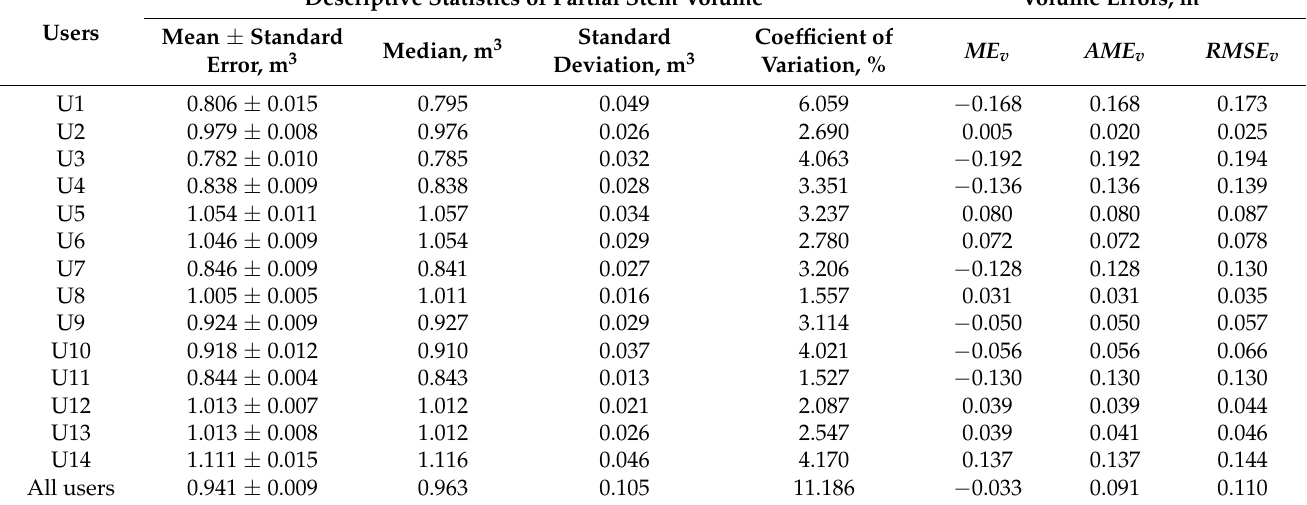
Table 6. Descriptive statistics of the partial stem volume estimated with Huber’s formula using a laser caliper and errors of volume estimates.